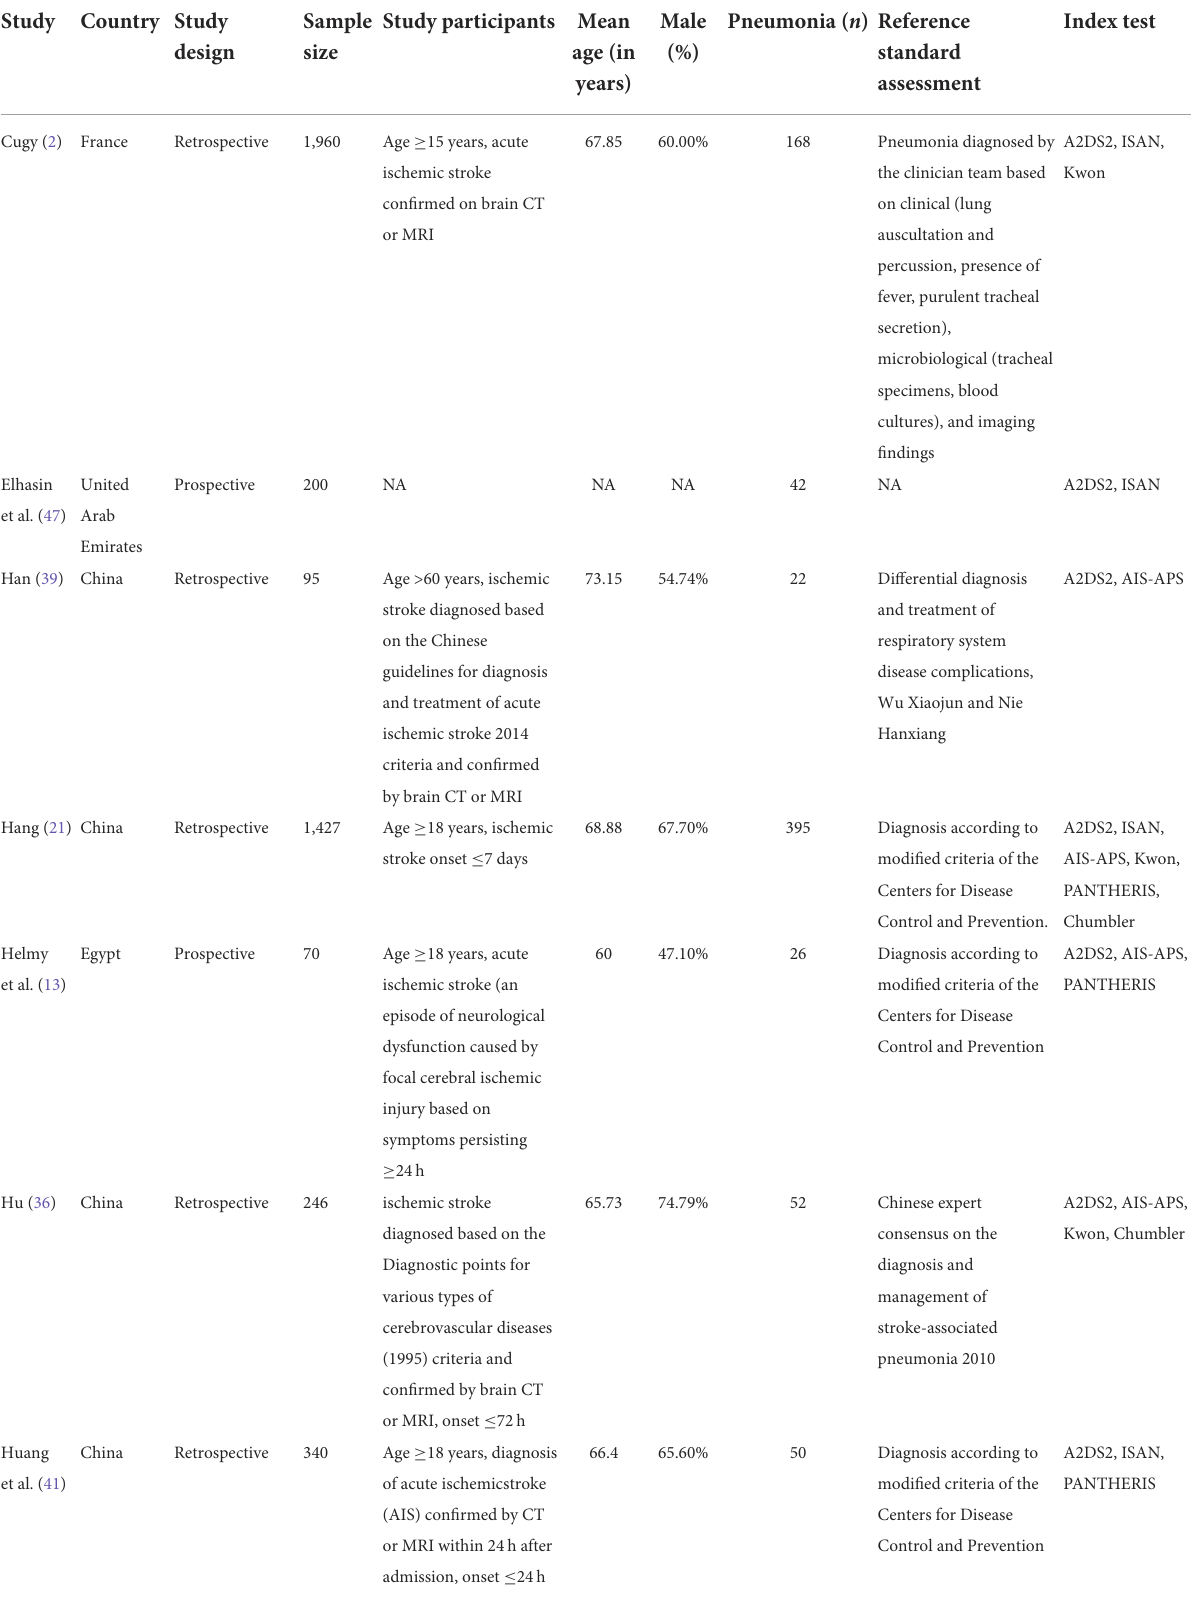
TABLE 1 Characteristics of the studies included in this